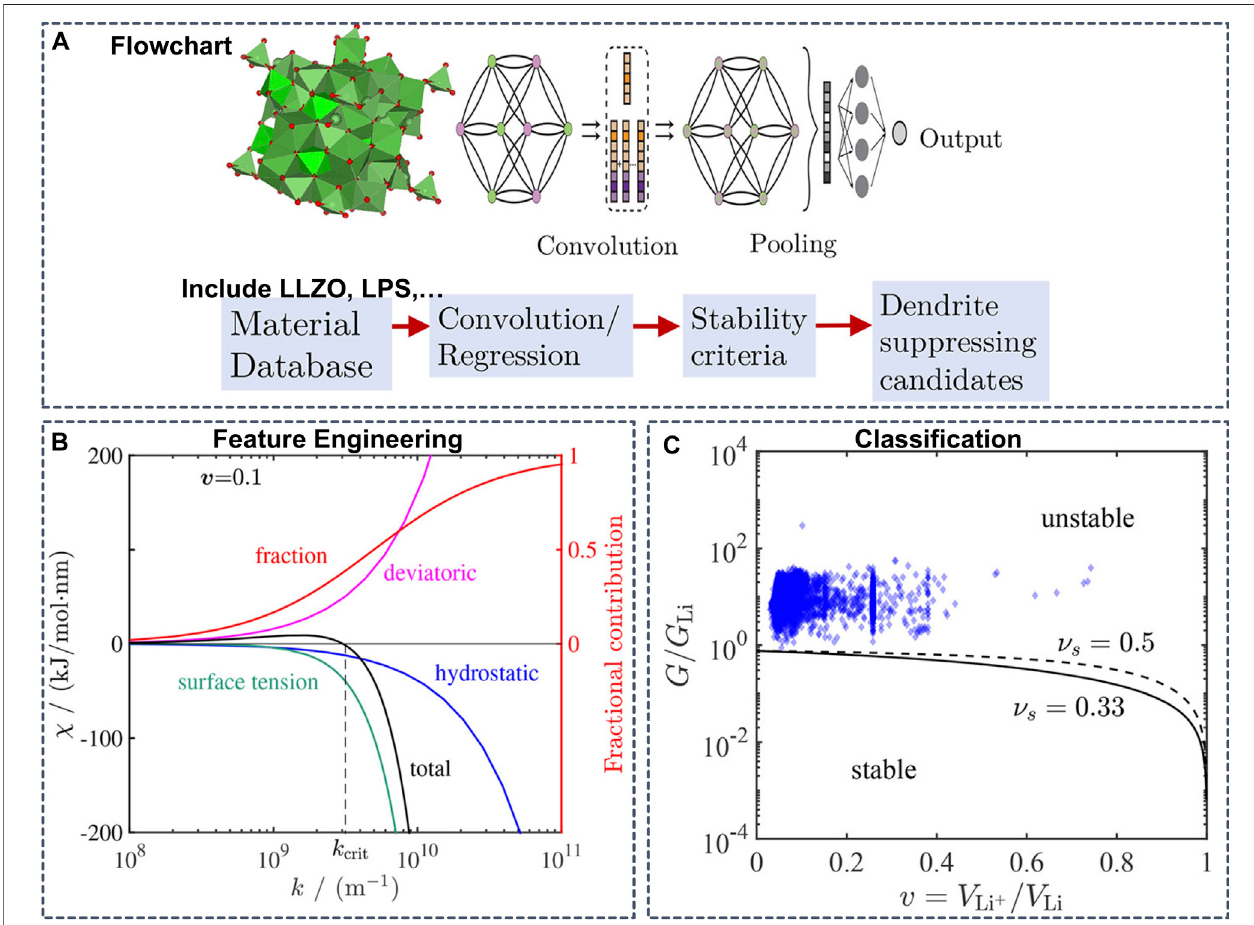
FIGURE 10 | (A) Flowchart of a graph convolutional neural network (B) Contribution of hydrostatic stress, deviatoric stress, and surface tension to the stability parameterasafunctionofsurfaceroughnesswavenumber. Thered lineshowsthefraction ofsurfacetensioncontribution tothestability parameter obtainedbydividing the absolute value of its contribution by the sum of absolute values of all components (C) Isotropic stability diagram showing the stability parameters of 2041 solid electrolytesconsideredinthescreening. G Li istheshearmodulusofLi( (cid:1) 3.4 GPa).Thecritical G / G Li lineseparatingthestableandunstableregionsdependsweakly on the Poisson ’ s ratio, so the lines corresponding to ] s (cid:1) 0.33 and 0.5 are good indicators for assessment of stability. Reproduced with permission from (Ahmad et